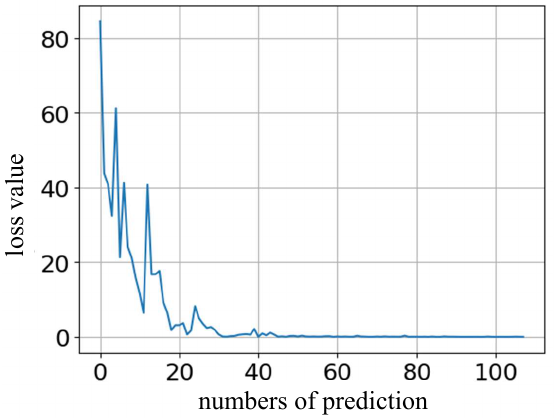
Figure 13. RNN Prediction Error